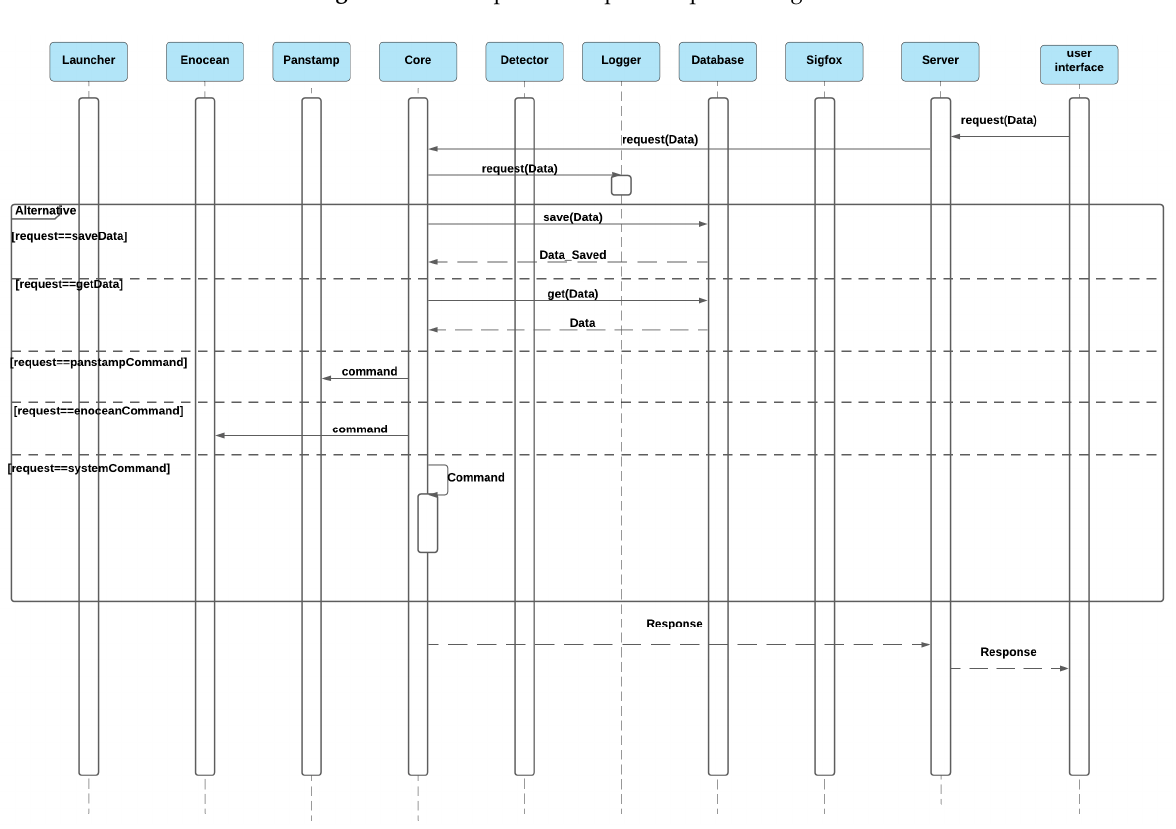
Figure 22. Sensor packet reception sequence diagram.